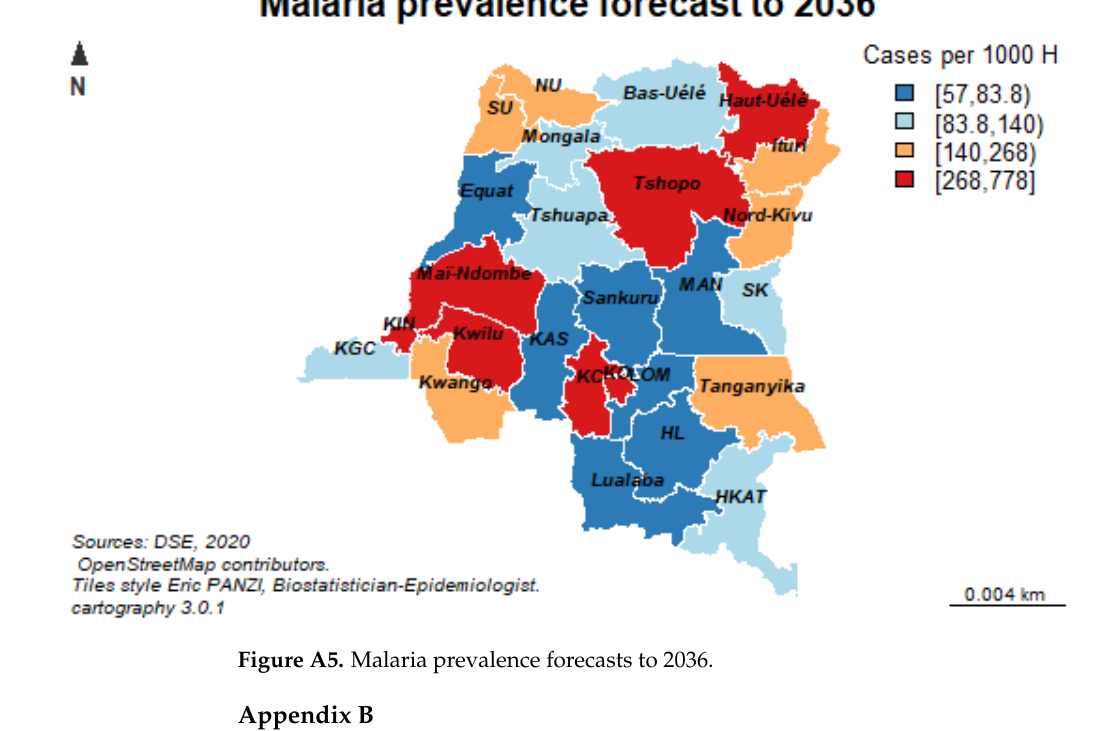
Figure A4. Malaria prevalence forecasts to 2035.